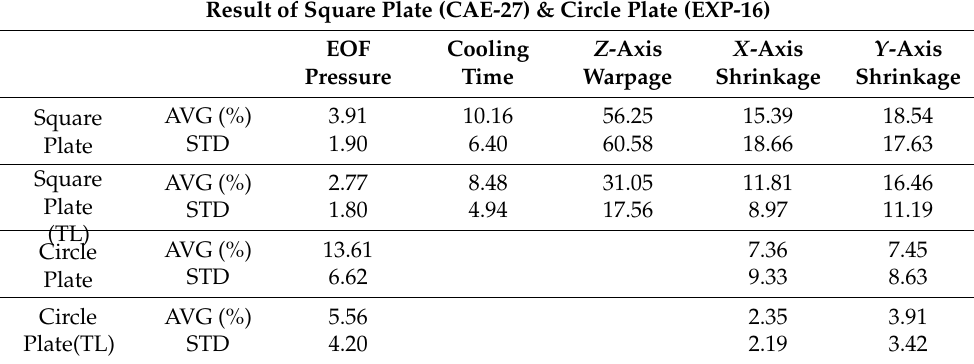
Table 25. Transfer learning results for square plate (CAE-27) and round plate (EXP-16). Result of Square Plate (CAE-27) & Circle Plate